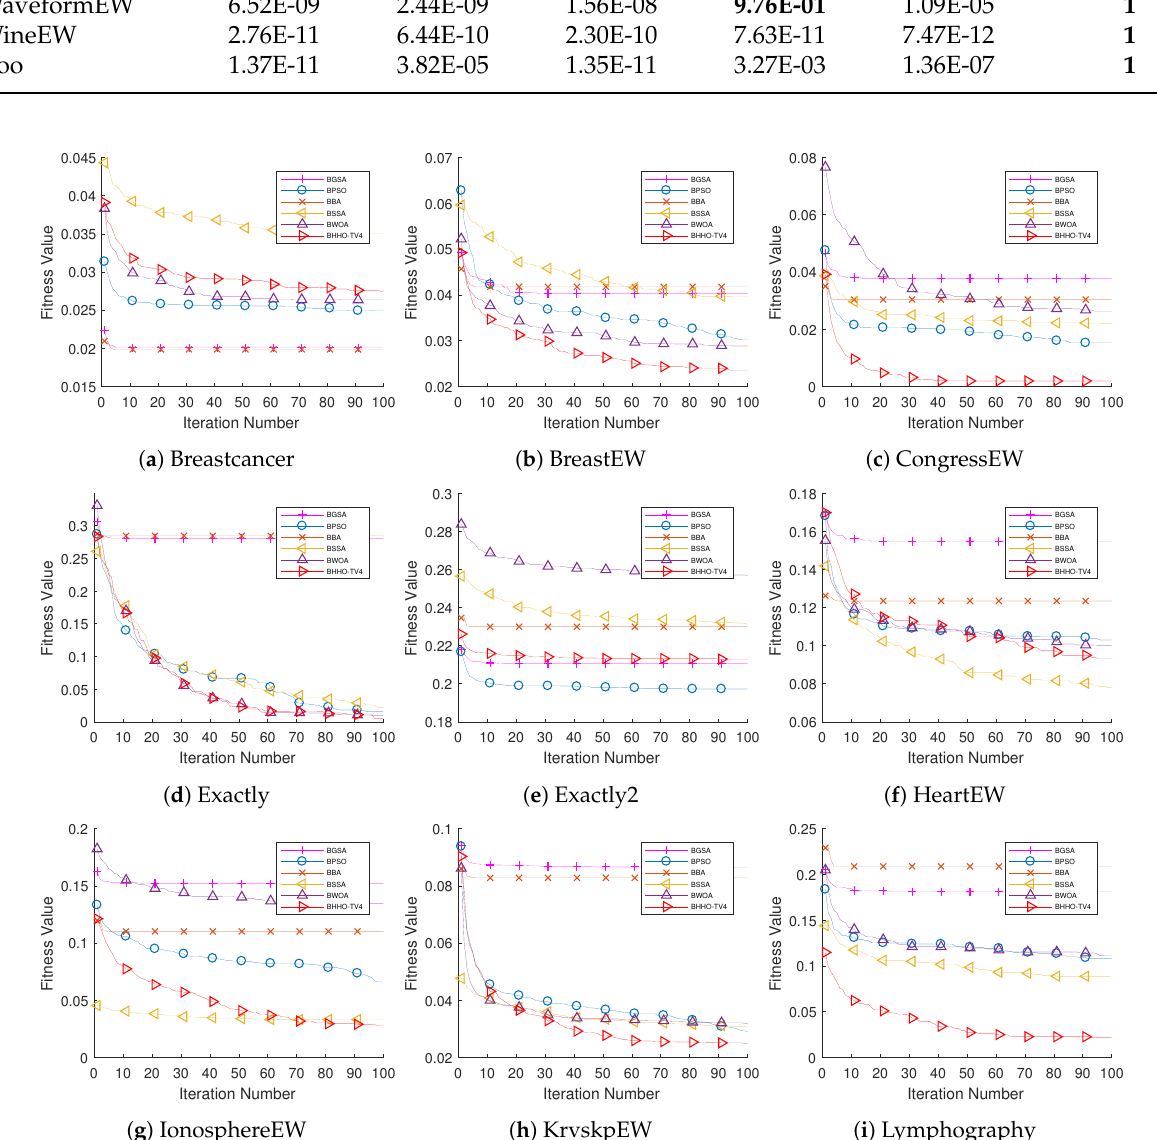
Figure 4. Convergence curves of BHHO TV 4 versus other competitors on Breastcancer, BreastEW, CongressEW, Exactly, Exactly2, HeartEW, IonosphereEW, KrvskpEW, and Lymphography